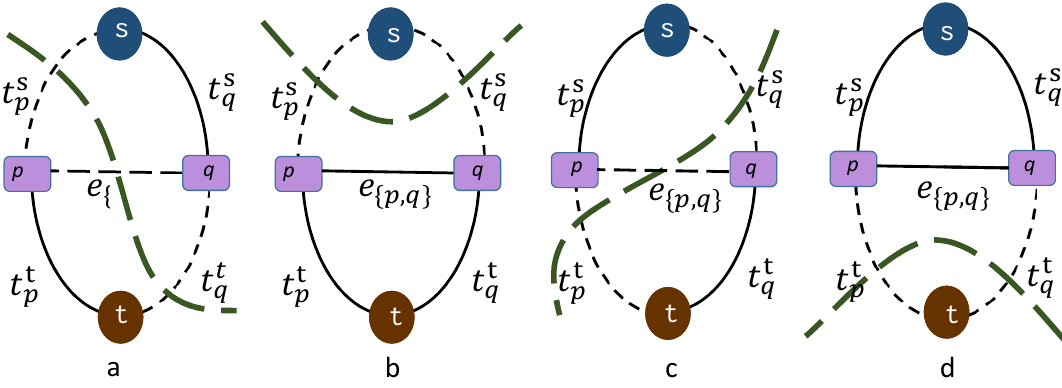
Figure 5. ( a – d ) For a graph with two pixels, four different cuts can be considered. The cost of each cut is equal to the sum of the weight of the respective dashed lines. The scenario with the smallest weight will be selected, and regarding the remaining edges in the graph, new labels for the pixels will be